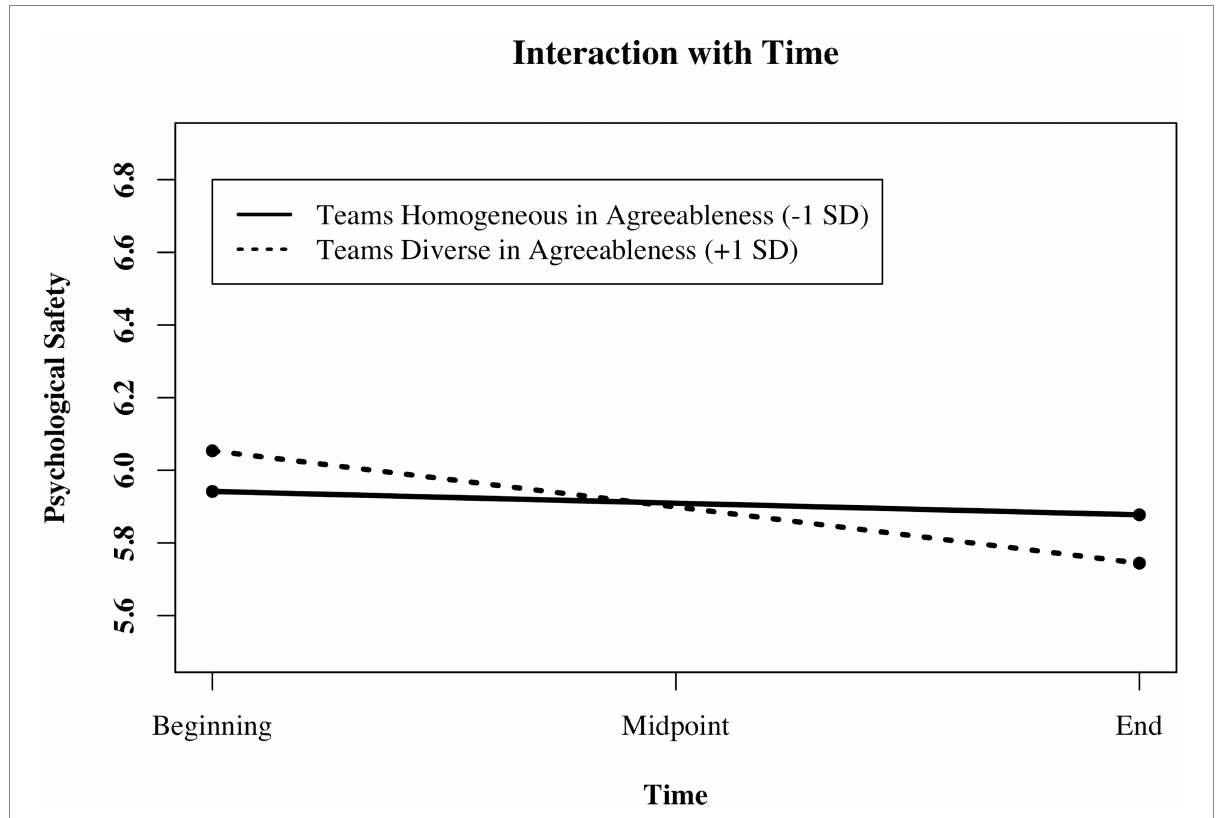
FIGURE 1 Illustration of the interaction between mean group member diversity in agreeableness (homogeneous vs. diverse) and time predicting changes in psychological safety in research teams ( N = 699 measurement points in time, nested in 233 members in 61